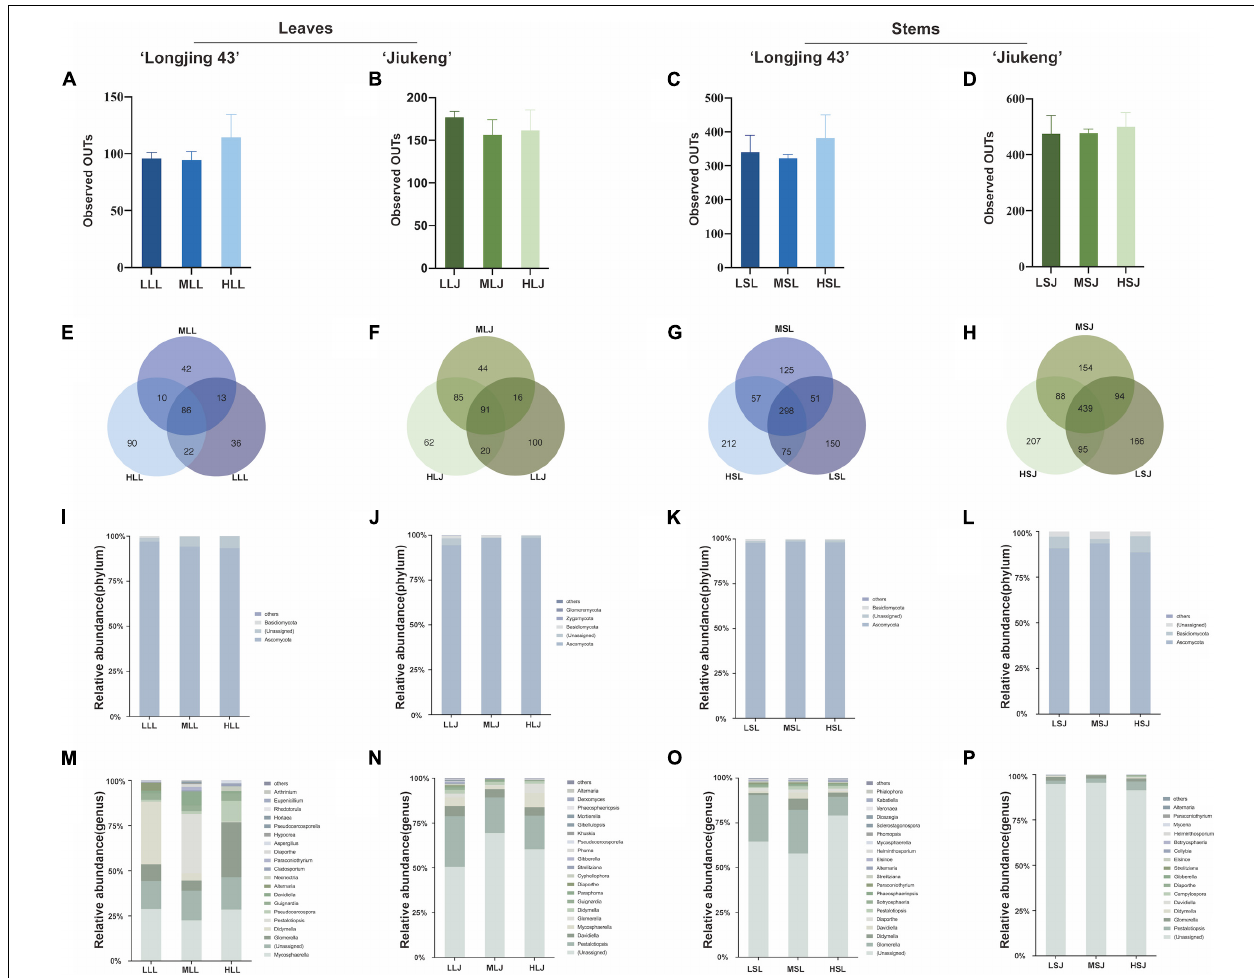
FIGURE 2 | Effects of sterilization treatments on the diversity of fungal endophytes from tea plant leaves and stems. (A–D) Alpha diversity of the fungal endophytic community; (E–H) Venn diagram showing the number of shared and unique operational taxonomic units (OTUs) (at 97% similarity); (I–L) relative abundance of fungal endophytes at the phylum level; (M–P) relative abundance of fungal endophytes at the genus level. LLL, MLL, and HLL represent the leaf samples from cultivar Longjing 43 treated with 0.5, 1.0, and 2.0% of NaClO. LLJ, MLJ, and HLJ represent the leaf samples from cultivar Jiukeng treated with 0.5, 1.0, and 2.0% of NaClO. LSL, MSL, and HSL represent the stem samples from cultivar Longjing 43 treated with 0.5, 1.0, and 2.0% NaClO. LSJ, MSJ, and HSJ represent the leaf samples from cultivar Jiukeng treated with 0.5, 1.0, and 2.0%